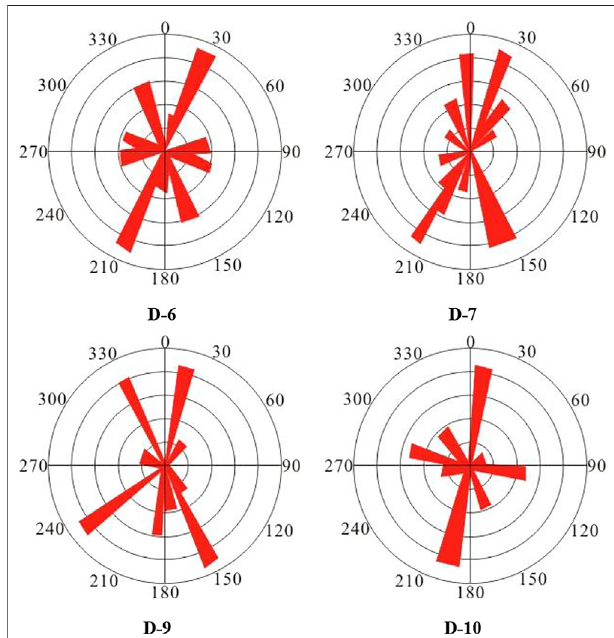
FIGURE 10 | Rose diagram of fracture strike of the Mesozoic volcanic rocks in the D oil fi eld of the Laizhouwan sag.